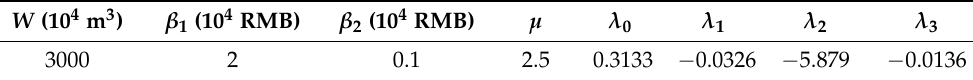
Table 4. Model parameters of experiment scheme 2.